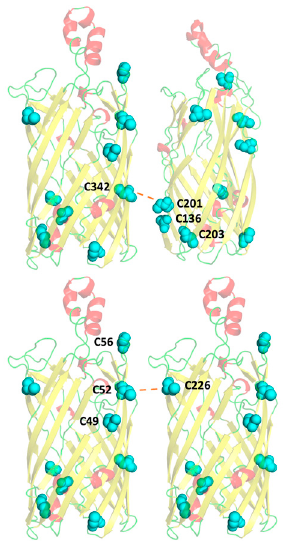
Figure 5. Two MOMP monomers indicating the hypothesised intermolecular disulphide bonds between C342 and C201, and C52 and C226. The nine cysteines residues are shown in cyan, with key residues labelled. Hypothesised intermolecular disulphide bonding is indicated by red dashed lines.